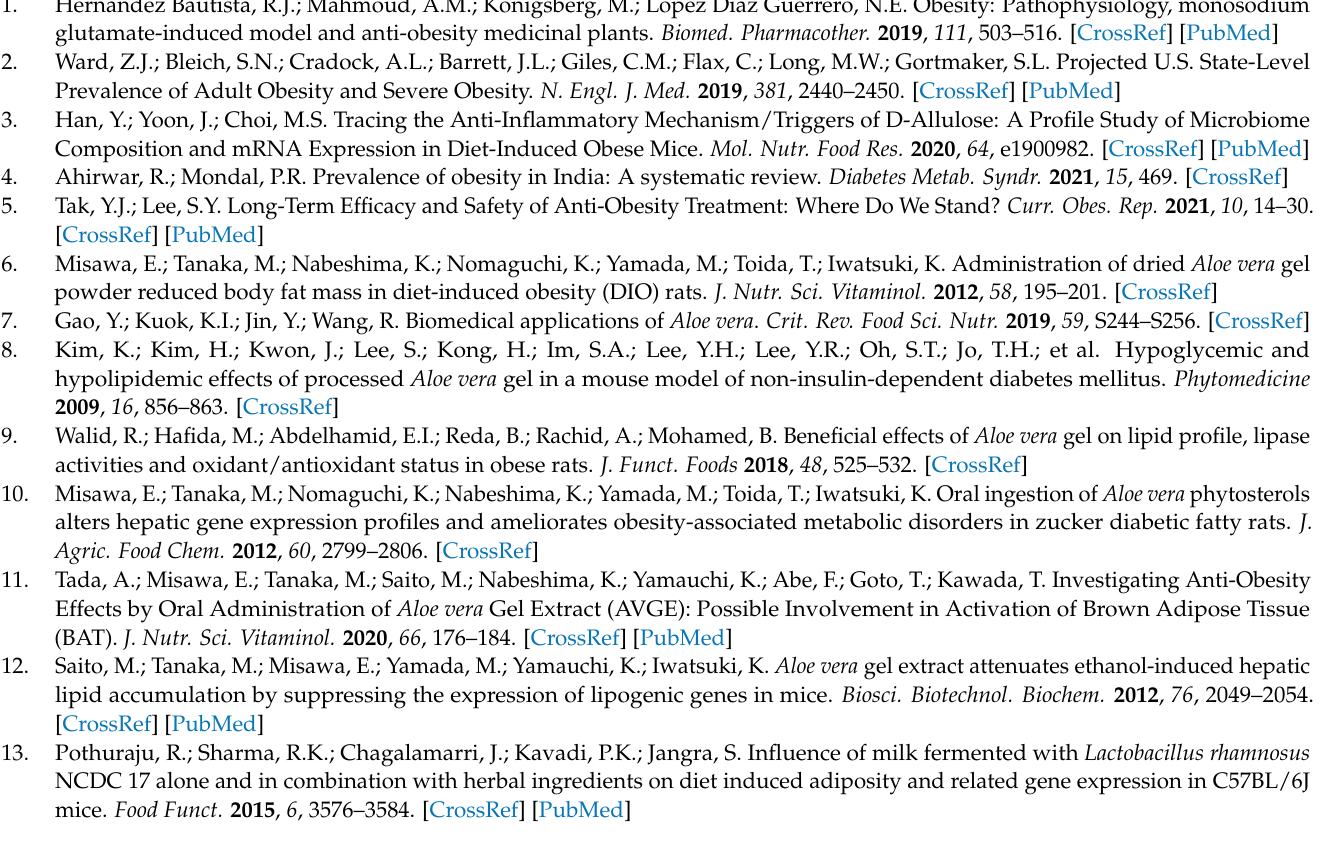
Table S2: The contents of different ingredients in different diet (% of diet, w / w